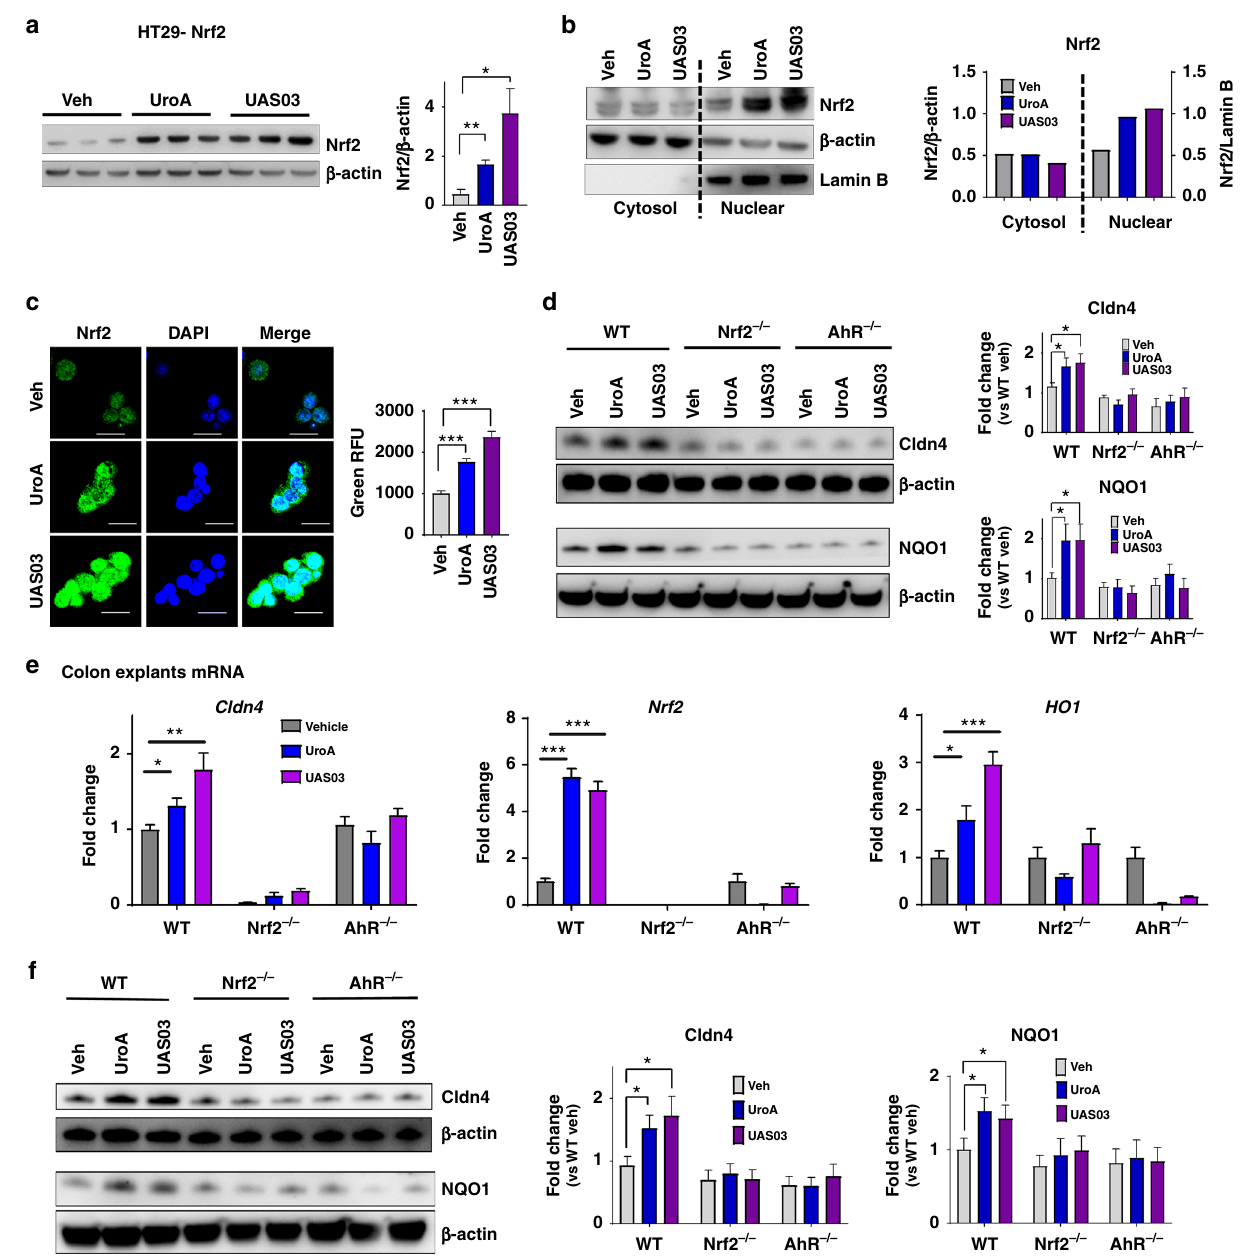
Fig. 3 Nrf2 is required for UroA/UAS03 mediated upregulation of tight junction proteins. a Nrf2 levels were determined by immunoblots in HT29 cells treated with vehicle/UroA/UAS03 (50 μ M) for 24 h. b Nrf2 expression in cytosolic and nuclear fractions of HT29 cells treated with Veh/UroA/UAS03 (50 μ M) for 6 h. c Immuno fl uorescence confocal images of HT29 cells treated with vehicle/UroA/UAS03 (50 μ M) for 6 h. The cells were stained with anti-Nrf2 antibody and DAPI. Relative green fl uorescence ( n = ~20 cells) intensity was measured. Scale bars indicate 25 μ m. d Expression of Cldn4 and NQO1 in colon explants from WT, Nrf2 − / − , and AhR − / − mice treated with vehicle/UroA/UAS03 (50 μ M) for 24 h. Immunoblots were quanti fi ed using Image J software. e mRNA levels of Cldn4, Nrf2 , and HO1 from colon explant cultures was measured by real-time PCR using SyBr green method. f C57BL/6, Nrf2 − / − , and AhR − / − mice ( n = 3) treated orally daily with veh or UroA/UAS03 (20 mg/kg) for 1 week. Cldn4 and NQO1 protein levels in colons were measured by immunoblots and quanti fi ed by Image J software. All in vitro studies were performed in triplicates. The immunoblots of colon explants and colon tissues were quanti fi ed from at least 6 independent runs. The levels of proteins were normalized to β -actin and Wild type vehicle treatment was set to 1 and calculated the fold changes. Statistics performed using unpaired t -test using Graphpad Prism software. Error bars, ±SEM; * p < 0.05; ** p < 0.01; *** p < 0.001. Source Data are provided as a Source Data